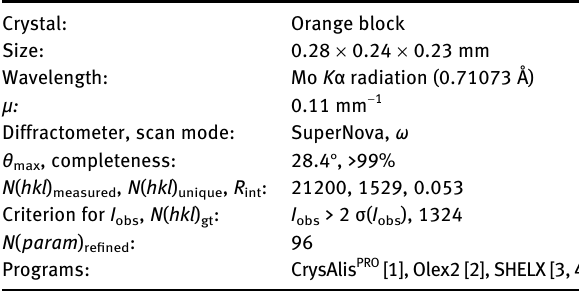
Table  : Data collection and handling.